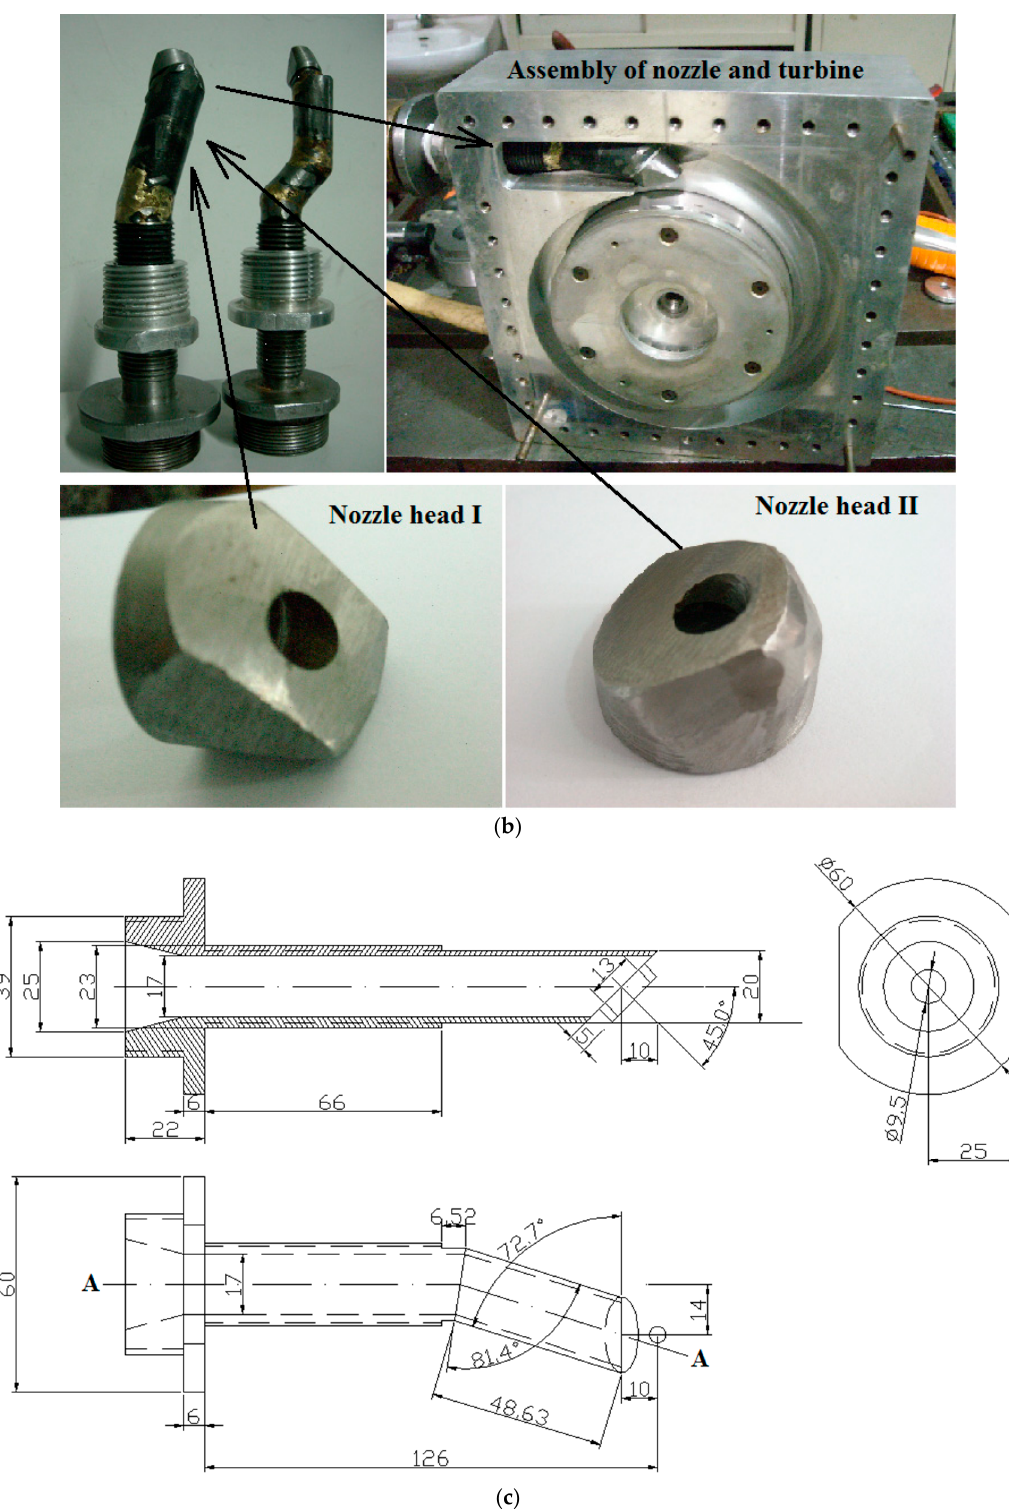
Figure 3. ( a ): Details of the radial flow turbine. ( b ): The assembly of the turbine nozzle. ( c ): Details of the nozzle without a nozzle head.